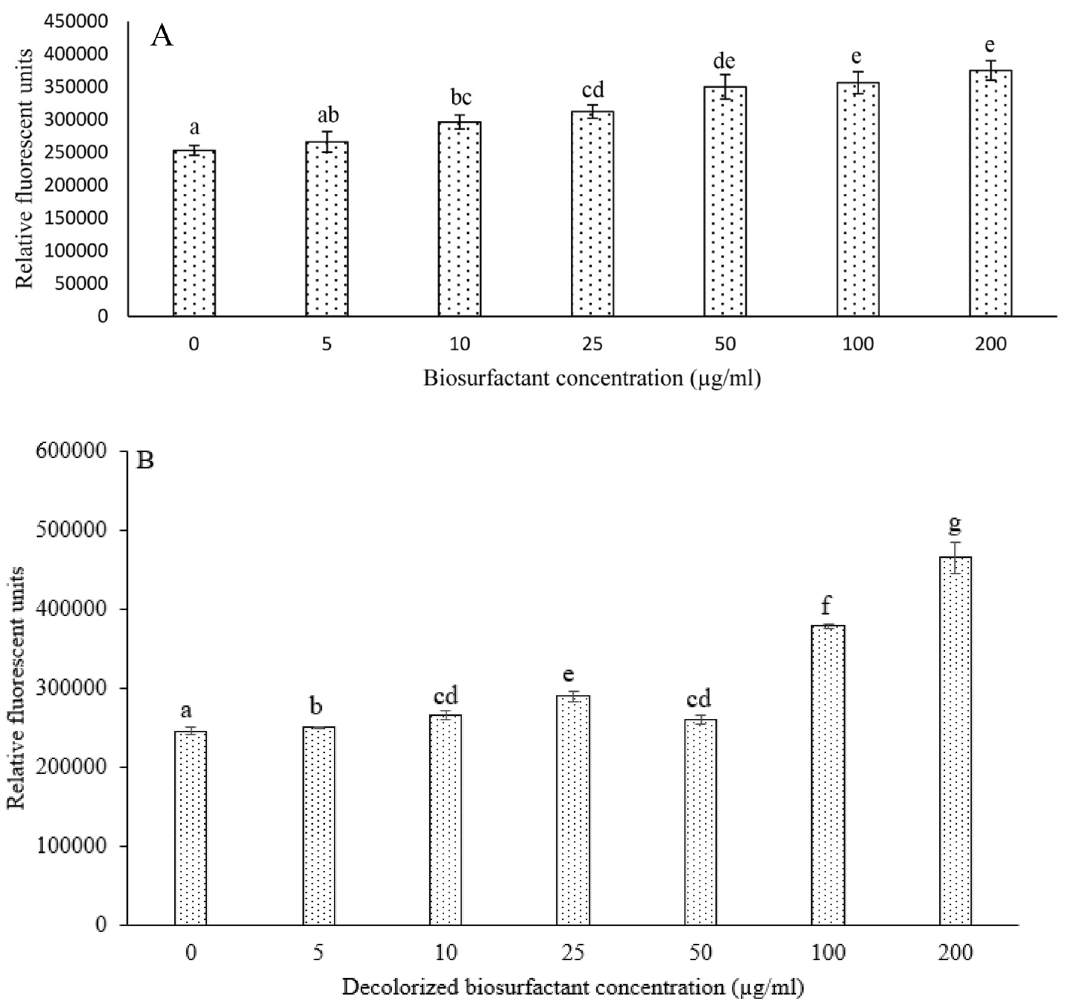
Figure 4. ( A ) Effect of biosurfactant on generation of reactive oxygen species (in terms of relative fluorescent units) on mouse skin fibroblast (M5S) cell line (sample size is147, Duncan’s multiple range test at df = 6) and ( B ) effect of decolorized biosurfactant on generation of reactive oxygen species (in terms of relative fluorescent units) on mouse skin fibroblast (M5S) cell line (sample size is 21, non-parametric Mann–Whitney test). Error bars in the graphs presents standard deviation. Similar letters on the columns indicate that there is no statistically significant difference at p > 0.05. Whereas dissimilar letters on the columns indicate that there is statistically significant difference at p <